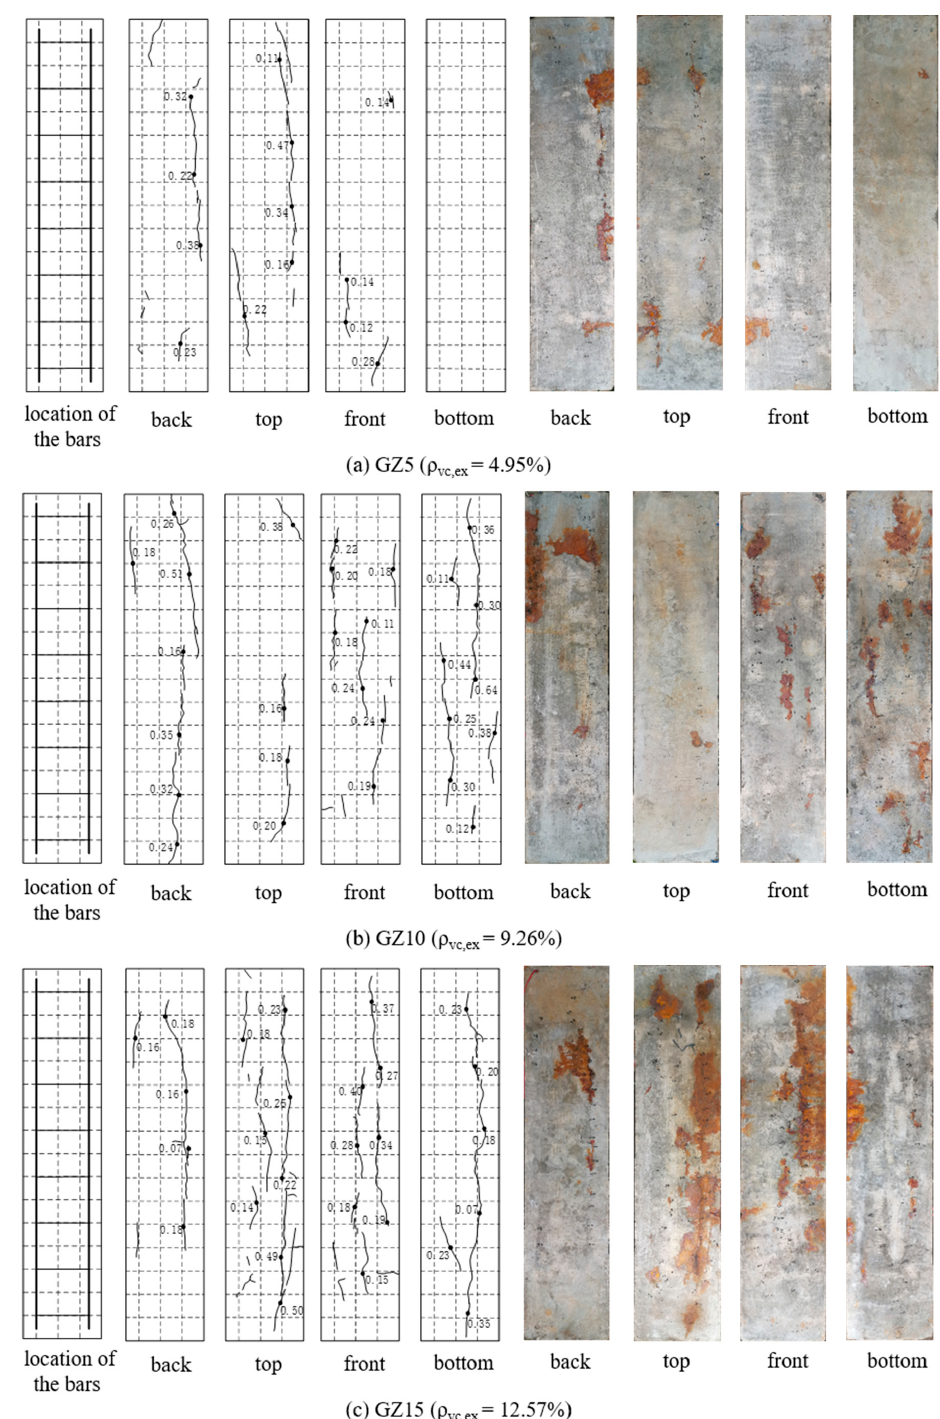
Figure 8. Corrosion-induced crack maps.